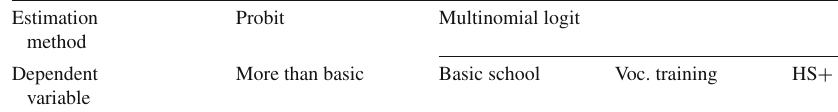
Table 11 The response of schooling attainment at age 25 to return to skill at age